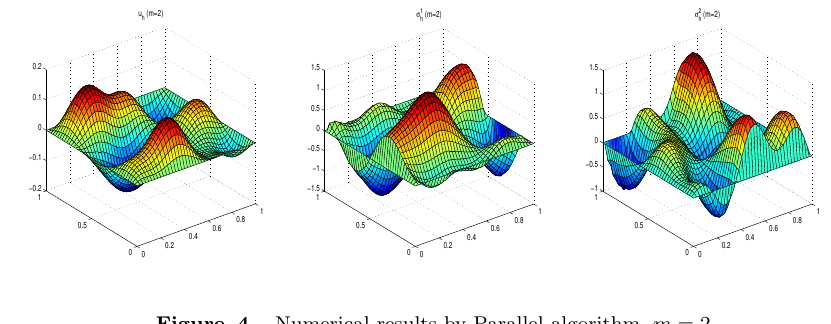
Figure 4. Numerical results by Parallel algorithm, m =